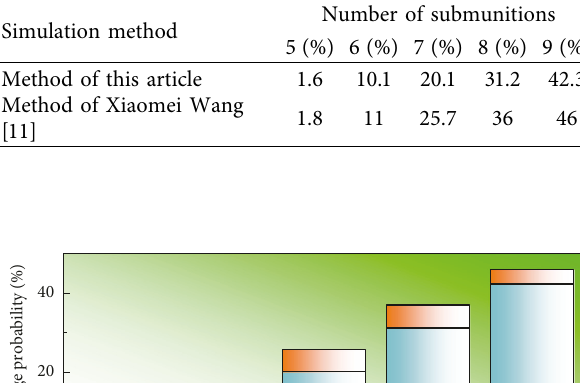
Table 5: Blockage probability simulation at 4000m runway length.